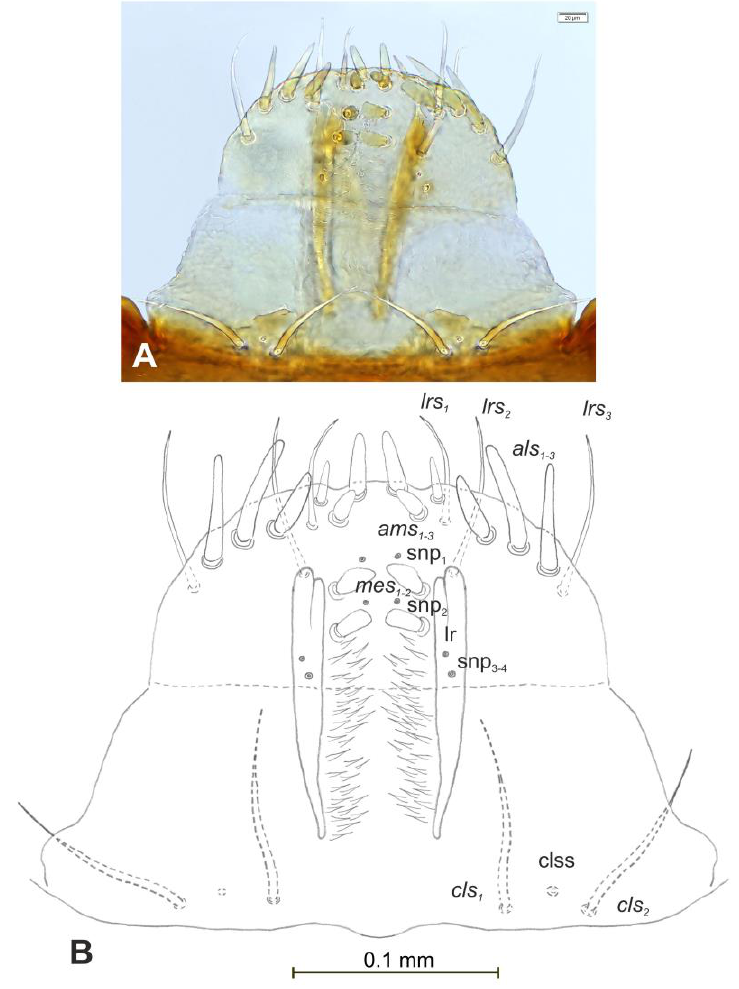
Figure 8. Euryommatus mariae mature larva, clypeus, labrum, and epipharynx. ( A ) Clypeus, labrum, and epipharynx, photo; ( B ) clypeus, labrum, and epipharynx, scheme (clss—clypeal sensorium, ds—digitiform sensillum, lr—labral rods, snp—sensillae pore, setae: als —anterolateral,